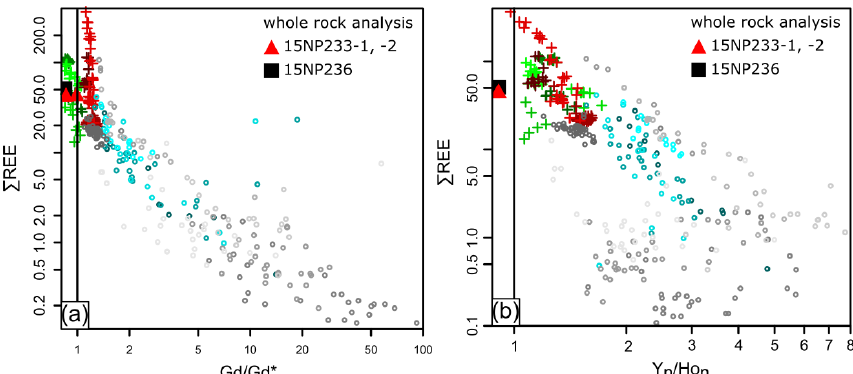
Figure 7. (a) Mixing trend between high total REE–negative Gd / Gd ∗ and low total REE–positive Gd / Gd ∗ composition. (b) Higher Y n / Ho n values correlate with low total REE. Y and Ho normalized against chondrite values of Anders and Grevesse (1989). +-15NP233, -236, o- 17NP436A, -B; color code see Appendix